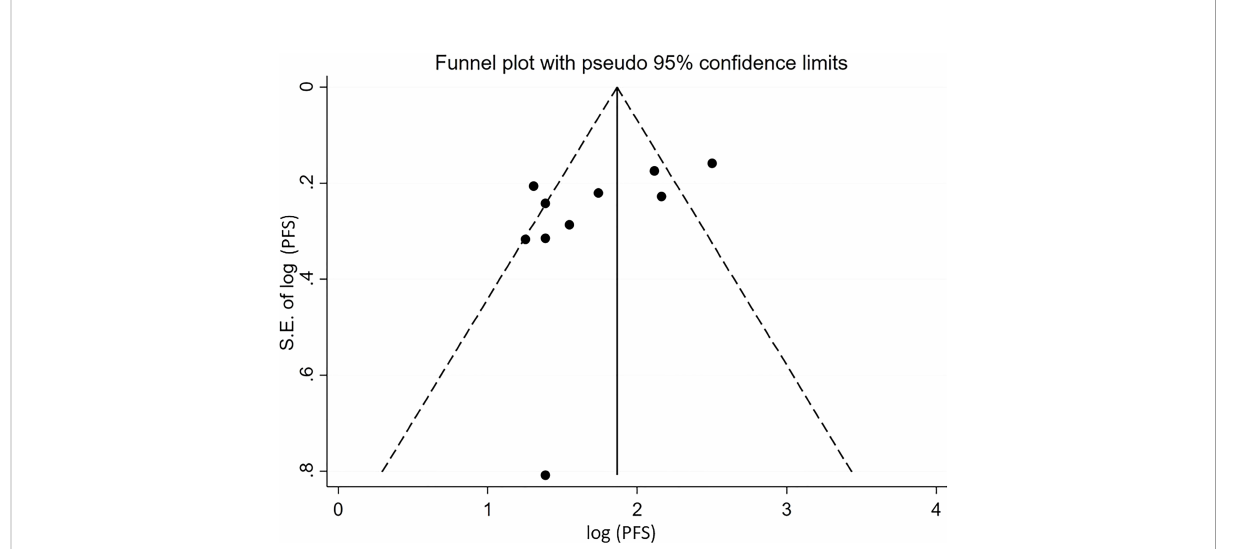
FIGURE 6 Funnel plot with pseudo 95% con fi dence limits for the estimation of the publication bias for the median progression-free survival (PFS) with the logarithm transformation.